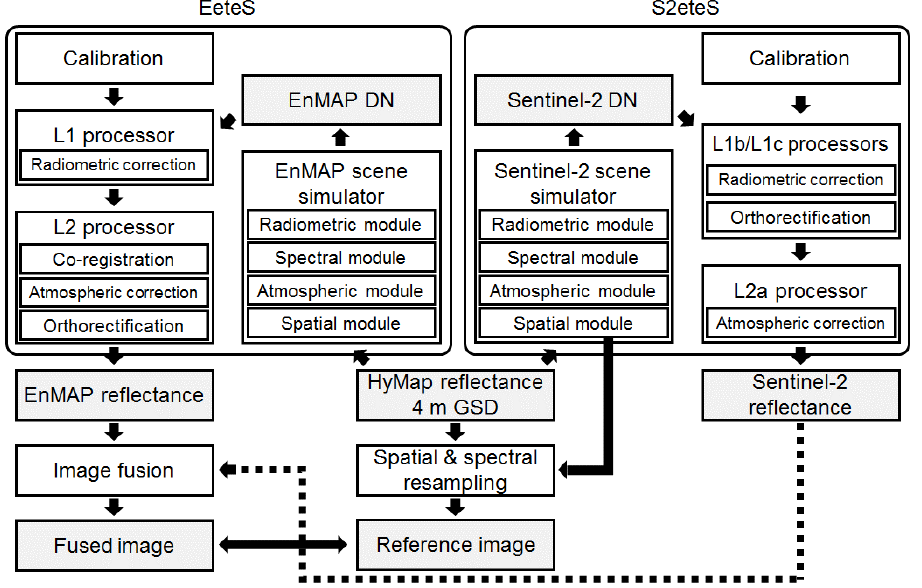
Figure 2. Flowchart of data preparation.